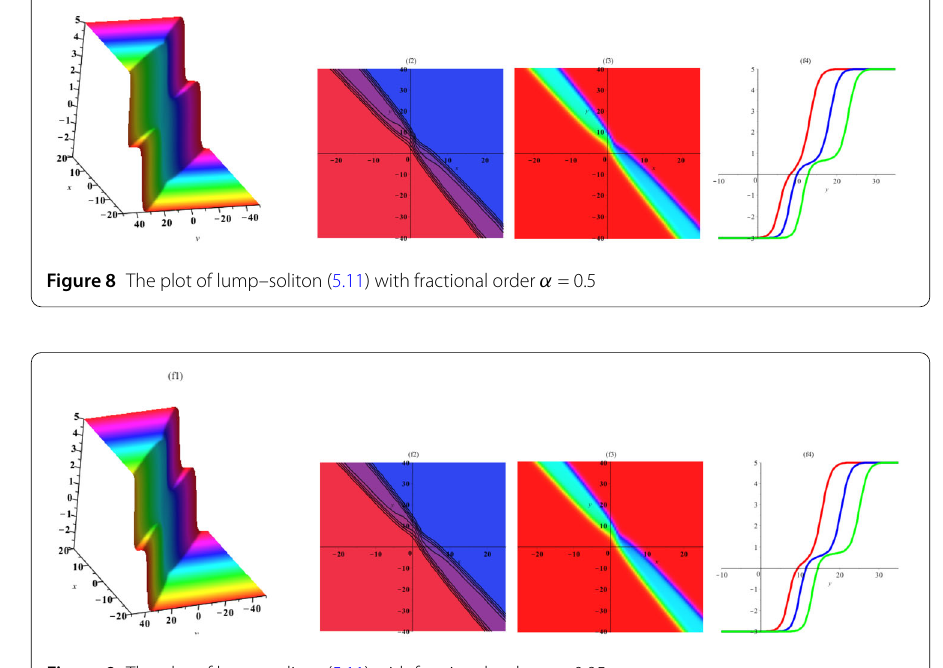
Figure 9 The plot of lump–soliton (5.11) with fractional order α =